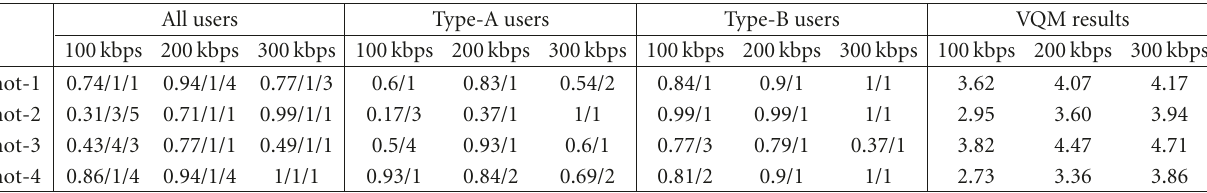
Table 4: The performance of our optimal operator selection algorithm: the Spearman rank correlation, the subjective rank of the option that our algorithm finds, and the subjective rank of the option that another objective metric finds (applicable for only all users part), respectively. VQM results show the VQM measure (scale 5) for the video with highest visual quality.